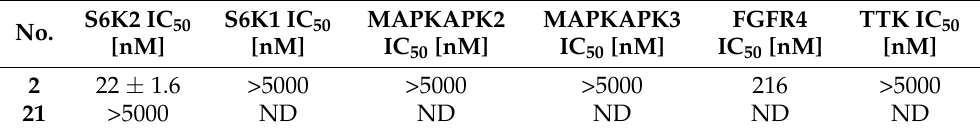
Table 1. Results of the biochemical kinase